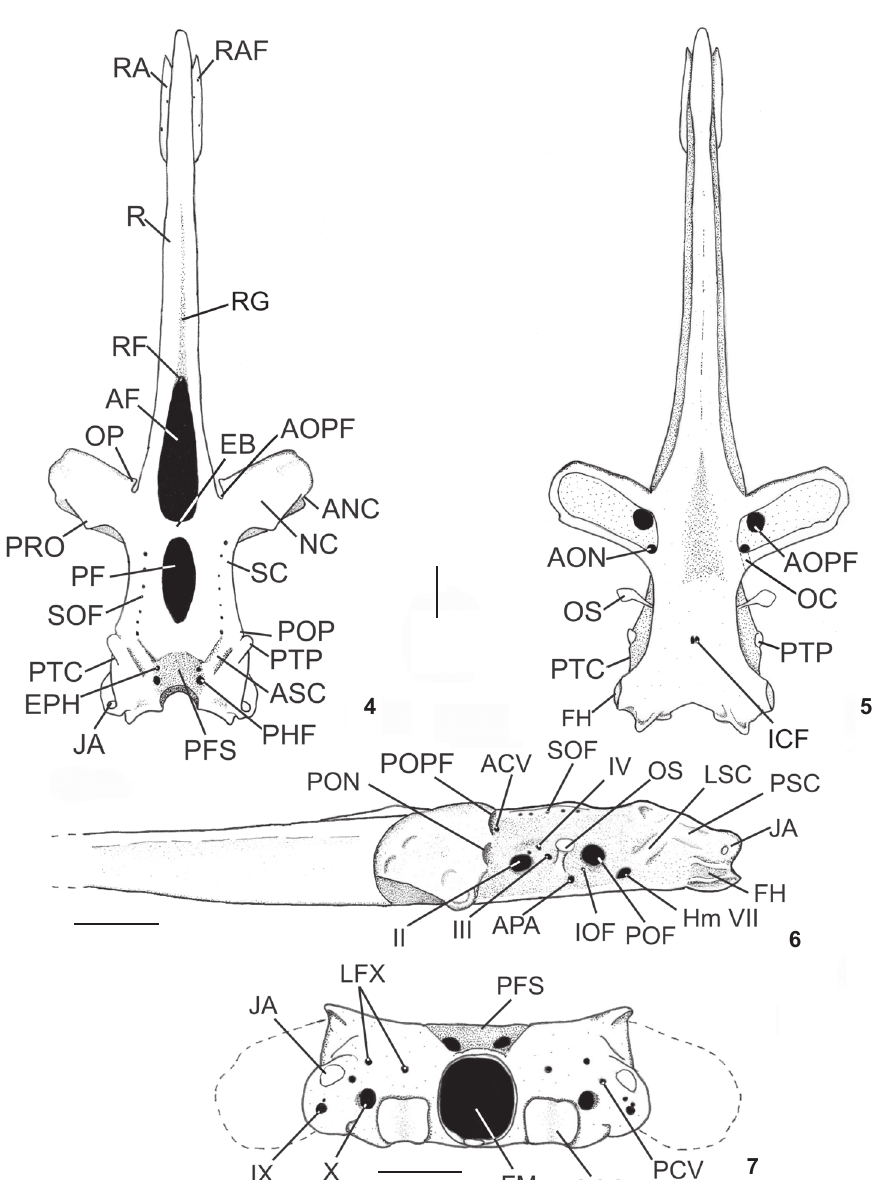
Figures 4-7. Neurocranium of D. mennii (UERJ 2104), in dorsal (4), ventral (5), lateral (6), and occipital (7) views. (ACV) anterior cerebral vein foramen, (AF) anterior fontanelle, (ANC) antorbital condyle, (AON) antorbital foramen, (AOPF) anterior ophthalmic foramen, (APA) afferent pseudobranchial artery foramen, (ASC) anterior semicircular canal, (ICF) internal carotid foramen, (EB) epiphysial bridge, (EPH) endolymphatic foramen, (FH) facet for hyomandibular cartilage, (FM) foramen magnum, (RG) rostral groove, (Hm VII) hyomandibular branch foramen, (IOF) internal orbital foramen, (JA) jugal arch, (LSC) lateral semicircular canal, (LFX) lateral foramen of the vagus nerve, (NC) nasal capsule, (OC) orbitonasal canal, (OCC) occipital condyle, (OP) ophthalmic process, (OS) optic stalk, (PCV) posterior cerebral vein foramen, (PF) posterior fontanelle, (PFS) parietal fossa, (PHF) perilymphatic foramen, (POF) prootic foramen, (PON) posterior orbitonasal foramen, (POP) postorbital process, (POPF) posterior ophthalmic foramen, (PRO) preorbital process, (PSC) posterior semi- circular canal, (PTC) pterotic crest, (PTP) pterotic process, (R) rostrum, (RA) rostral appendix, (RAF) rostral appendix foramen, (RF) rostral foramen, (SC) supraorbital crest, (SOF) supraophthalmic foramen, (II) optic nerve foramen, (III) oculomotor nerve foramen, (IV) trochlear nerve foramen, (IX) glossopharyngeal nerve foramen, (X) vagus nerve foramen. Scale bars: 4-5 = 40 mm, 6-7 = 30